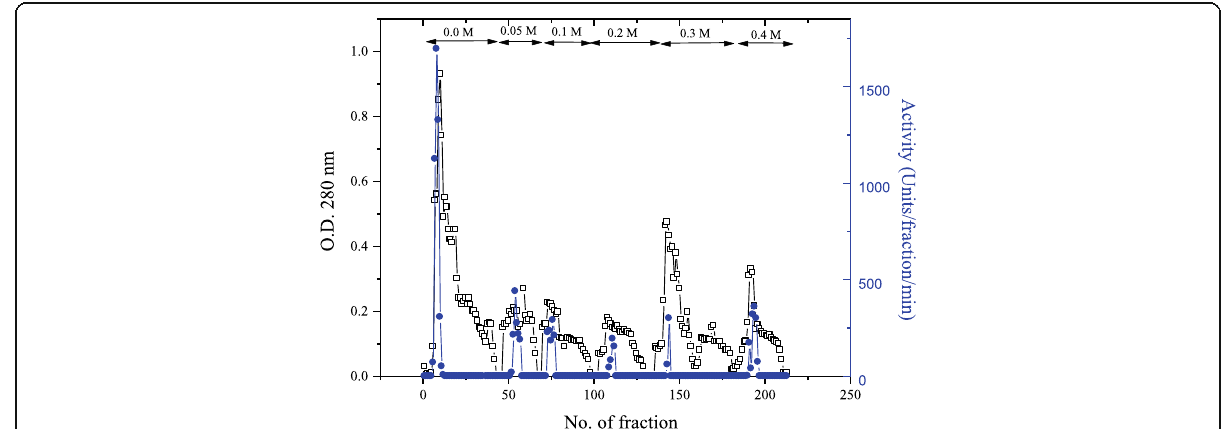
Fig. 1 A typical elution profile for the chromatography of ginger peroxidase on DEAE-Sepharose column (6 × 1.6 cm i.d.) previously equilibrated with 20 mM Tris-HCl buffer, pH 7.2, at a flow rate of 30 ml/h and 5 ml